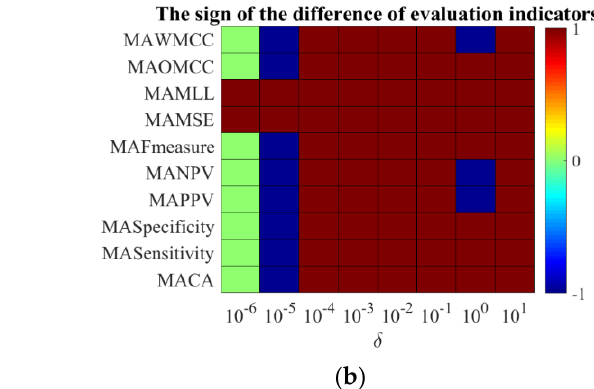
Figure 11. Comparisons between GDCA driven SVM and original SVM regarding the mean and standard deviation of all the Monte − Carlo experiments for ACA and AMLL. ( a ) The mean of ACA (MACA). ( b ) The sign of the difference of MACA. ( c ) The standard deviation of ACA. ( d ) The mean of AMLL (MAMLL). ( e ) The sign of the difference of MAMLL. ( f ) The standard deviation of AMLL.